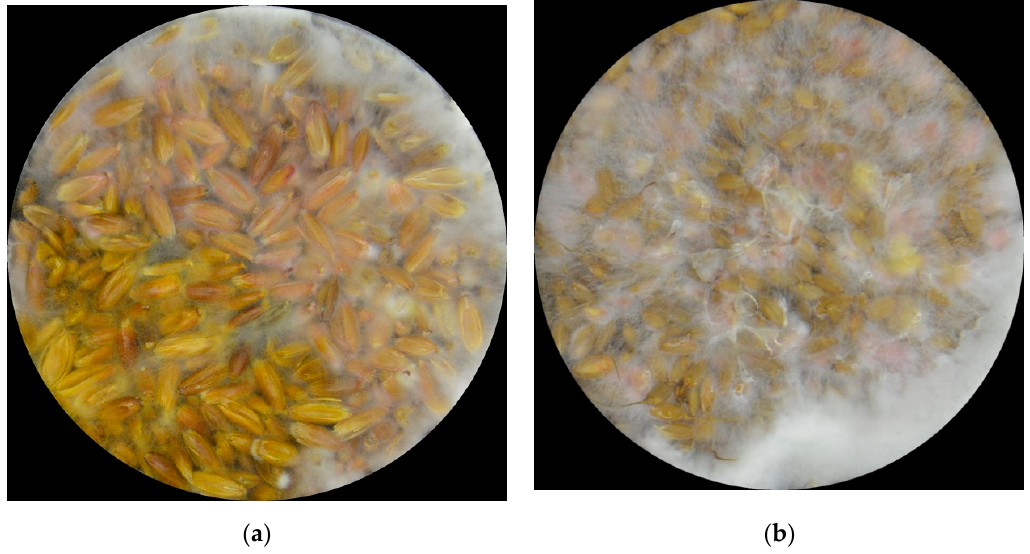
Figure 1. Fusarium graminearum at a w = 0.99 after 8 days in heavily contaminated ( a ) oats and ( b )